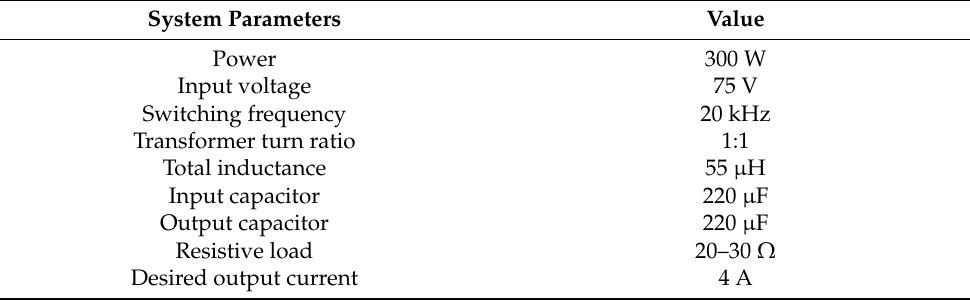
Table 3. DAB–DC/DC electrical specifications used for Lab